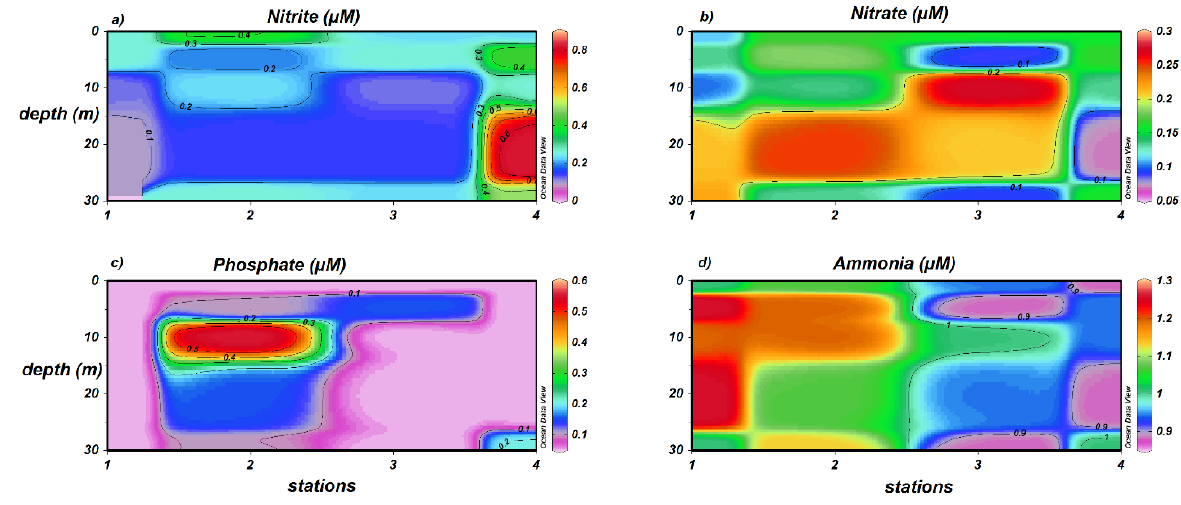
Figure 3: Surface distribution pattern of a) DO and b) pH; cross-section profile of c) pH and d) DO.